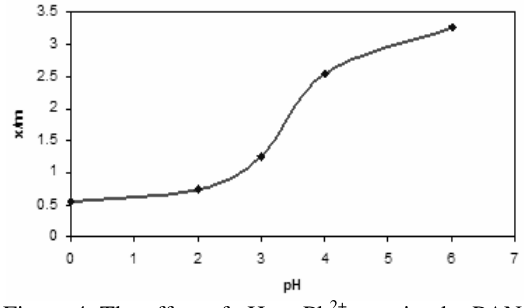
Figure 4. The effect of pH on Pb 2+ sorption by PANi